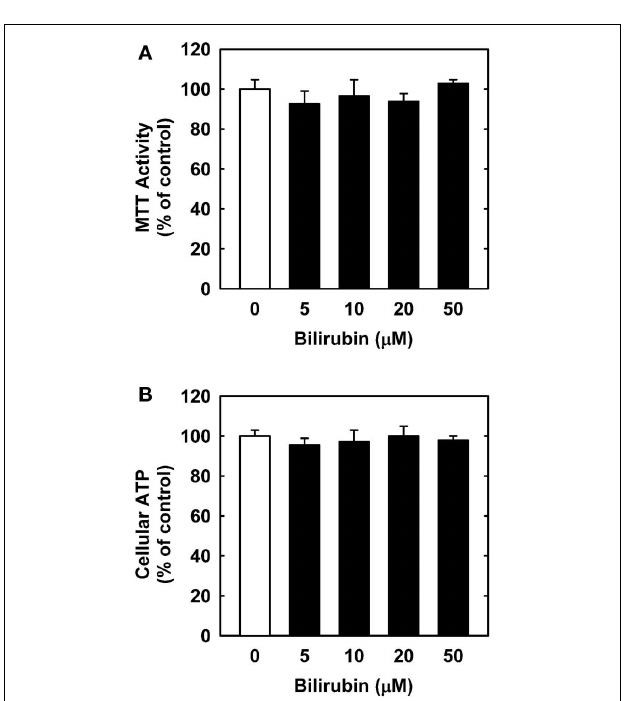
FIGURE 6 | Bilirubin has no effect on mitochondrial function orATP content in human vascular SMCs. (A) Effect of bilirubin on mitochondrial function. (B) Effect of bilirubin on ATP content. Cells were treated with serum (20%) in the absence or presence of bilirubin (0–50 μ M) for 24h. Results are means ± SEM ( n =